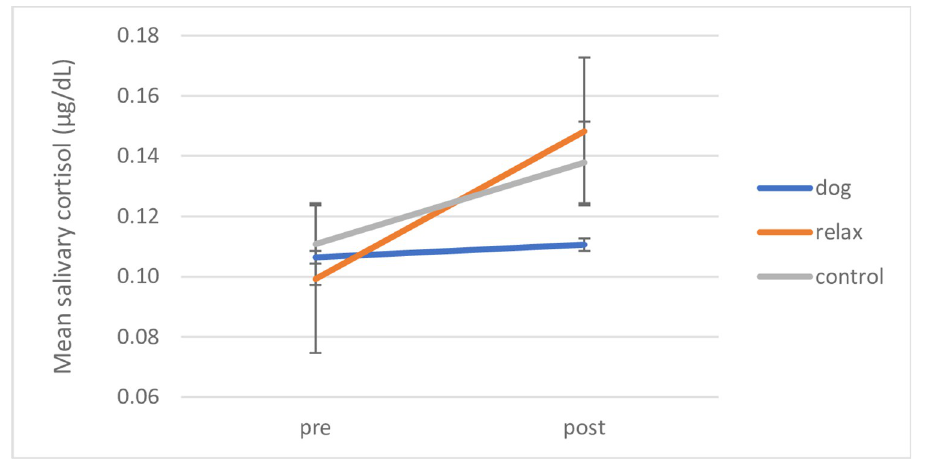
Fig 4. Individual interventions: Mean pre-post salivary cortisol by intervention condition (dog, relax, no treatment control). Mean pre-post salivary cortisol levels shown by intervention condition (dog, relax, no treatment control). Error bars indicate standard error of